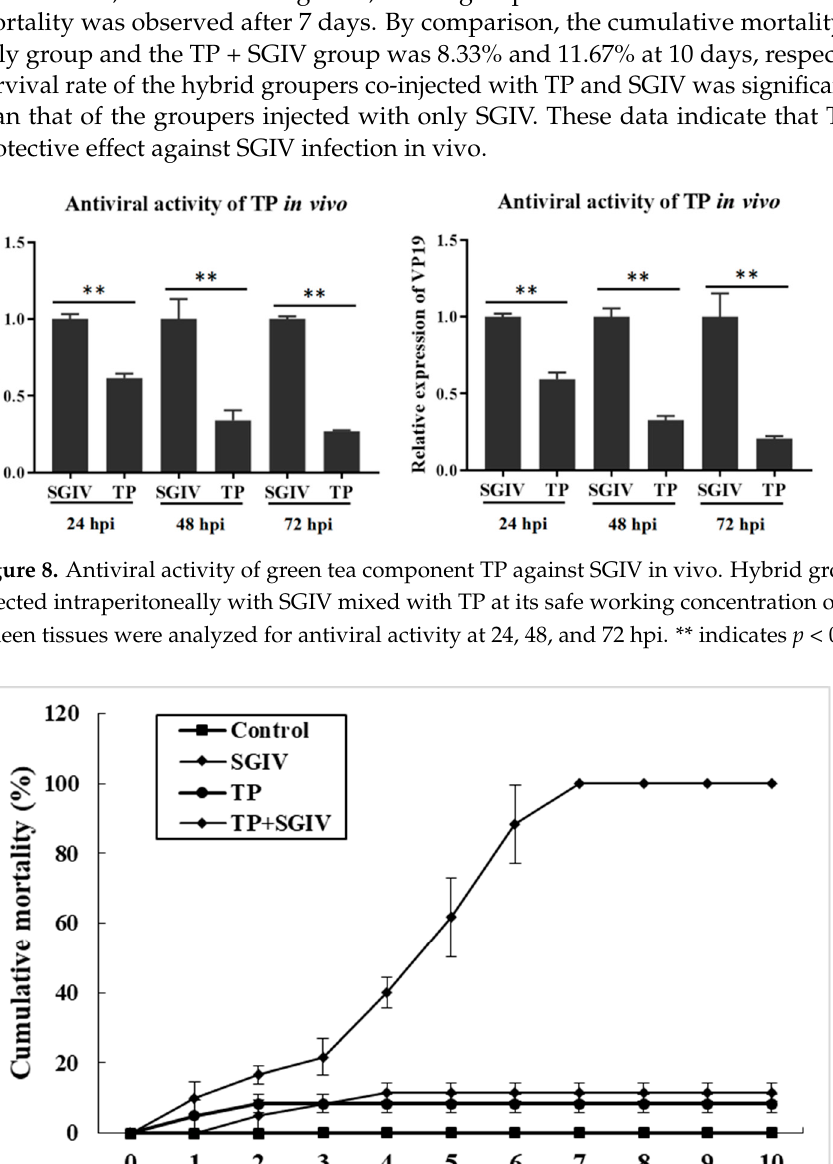
Viruses 2022 , 14 , x FOR PEER REVIEW 9 of 13 Figure 7. Percentage inhibition analysis of each green tea component against SGIV infection. The percentage inhibition of SGIV infection by each green tea component was 99.44% (GTAE), 99.79% (TP), and 99.99% (EGCG) when measured as MCP expression and 98.60% (GTAE), 99.83% (TP), and 99.99% (EGCG) when measured as VP19 gene expression. 3.5. Antiviral Activity of TP against SGIV In Vivo